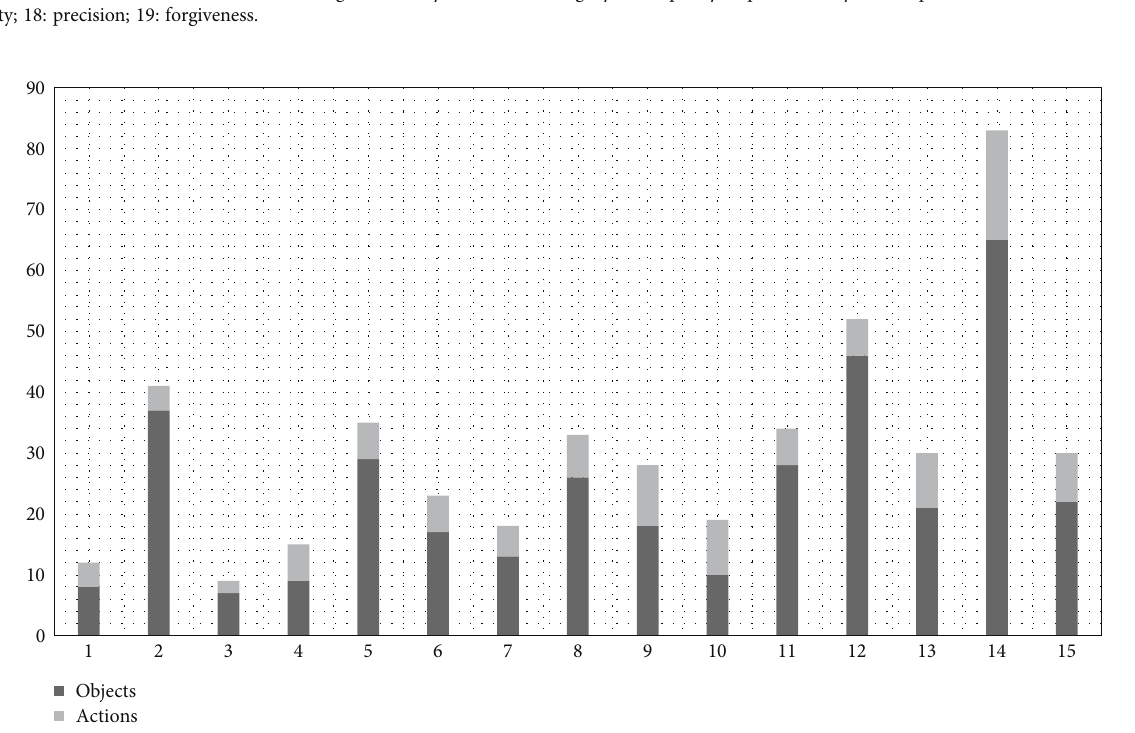
Figure 4: Distribution of objects and actions among the several interface screens. Notes: 1: user authentication screen; 2: account creation screen; 3: password recover screen; 4: timeline screen; 5: sensor overview screen; 6: sensor details screen (table format); 7: sensor details screen (chart format); 8: sensor edition screen; 9: sensor troubleshoot screen; 10: sensor measurements screen; 11: look and feel settings screen; 12: user pro fi le screen; 13: equipment settings screen; 14: noti fi cations settings screen; 15: data management settings